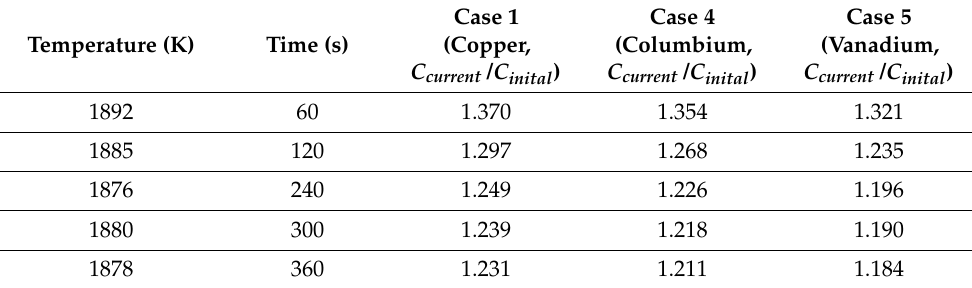
Table 5. Scaled mass fraction of alloy concentrations recovered.